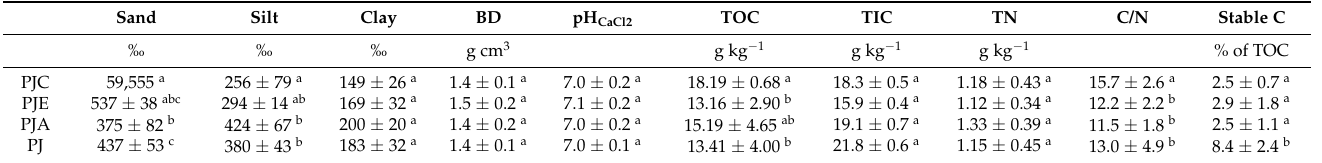
Table 3. Soil data of the different intercropping systems. Values are mean and standard deviation of 24 replicates, with the exception of sand, silt, clay and recalcitrant C that are mean and standard deviation of three samples. BD = bulk density; TOC = total organic carbon, TIC = Total inorganic Carbon; TN = total nitrogen. The superscript letters ( a,b,c ) indicate significant differences between means in the different column and for each system, according to One-way ANOVA, followed by Student–Newman–Keuls coefficient for comparison tests ( p < 0.05). Systems that do not share at least one letter are significantly